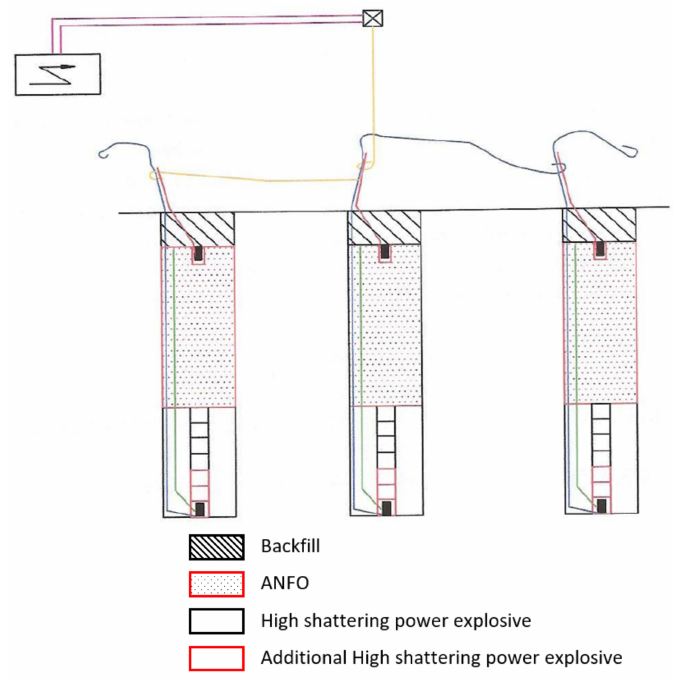
Figure 3. Standard central connection of the previous